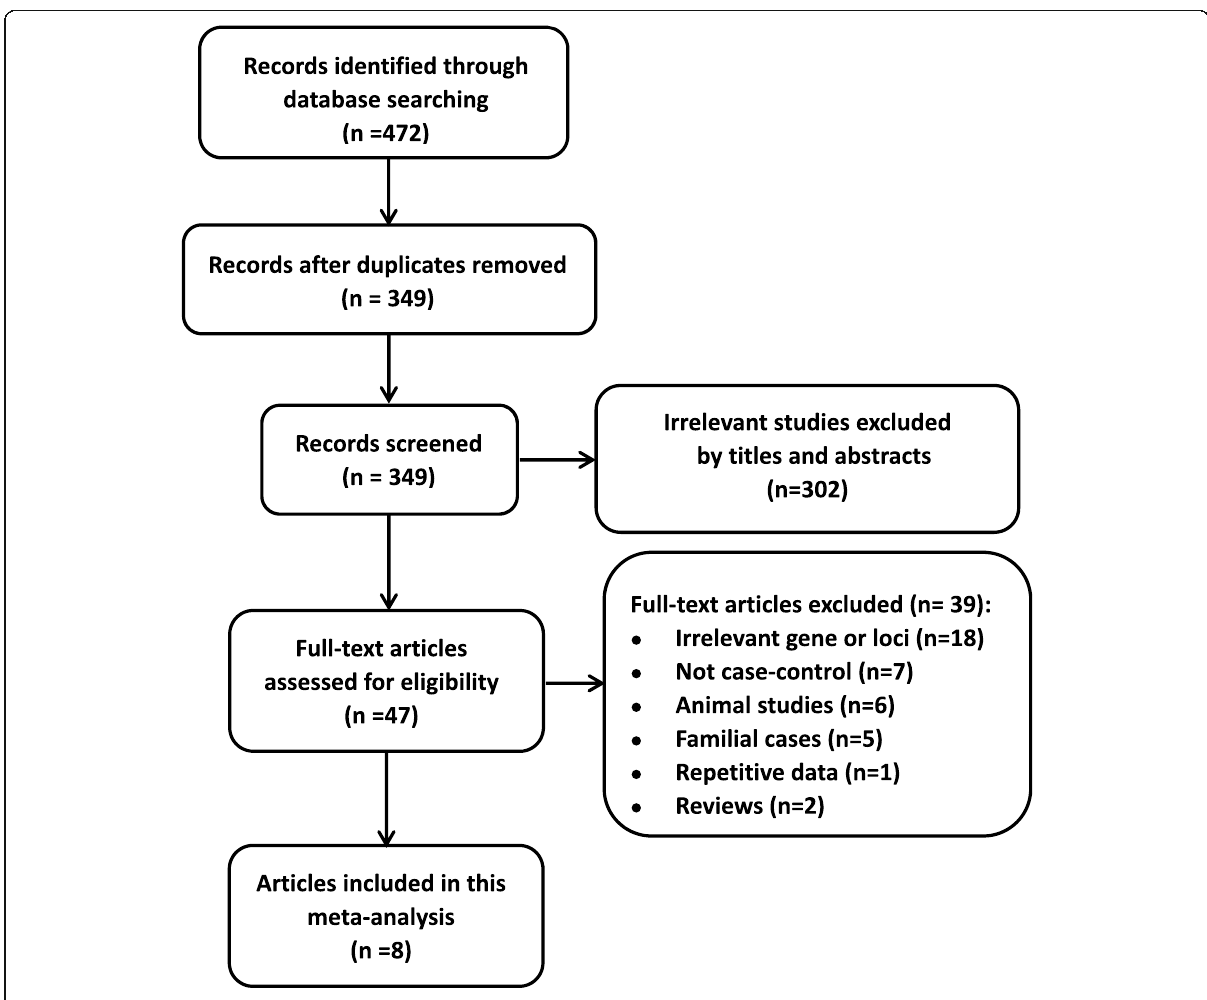
Fig. 1 Flow chart of study selection. Ultimately, 8 articles were